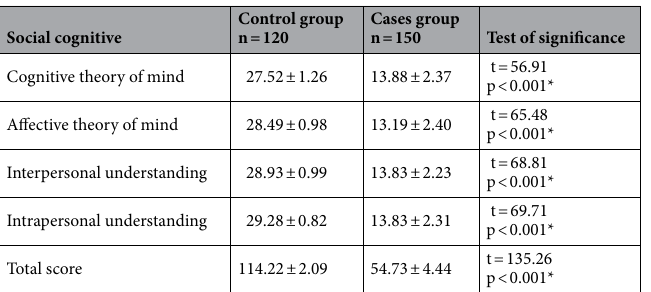
Table 5. Comparison of mean social cognitive score between studied groups. t: Student t test, *statistically significant if p < 0.05, parameters described as mean ± SD.